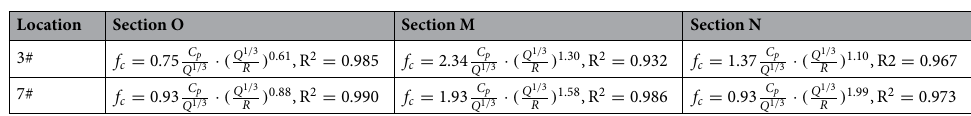
Table 2. f c fitting formula of measuring points 3# and 7# at different tunnel spacings.